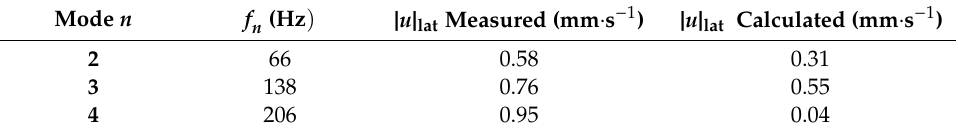
Table 2. Experimentally obtained | u | lat compared to values calculated using the model of the Stokes drift. Measured values | u | lat are the same as in Figure 6, S = 60 ◦ . w max was determined by µ PIV as described in the methods and taking a local average of z -velocities around the maximum z -velocity found in the vector field.